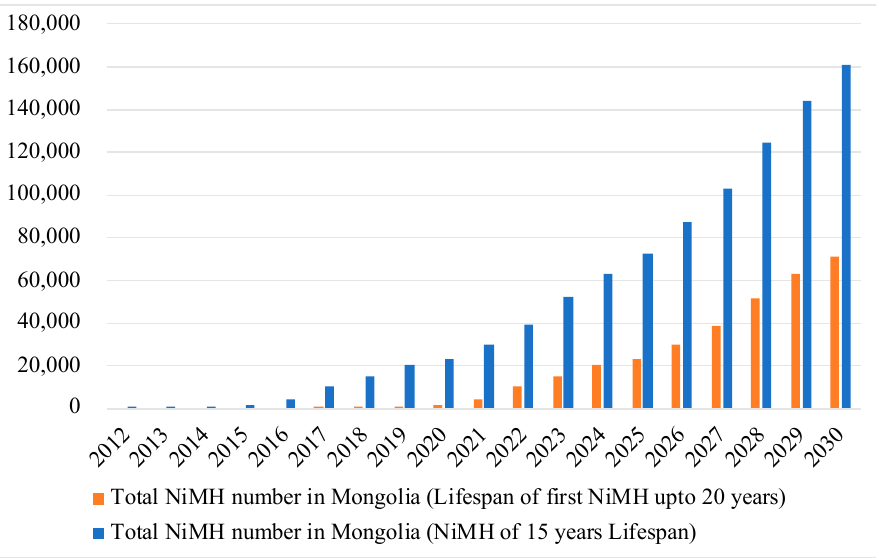
Figure 8. Estimated End-of-Life NiMH battery in Mongolia. Source: Figure made by the author based on the data from previous studies [10,24,25].